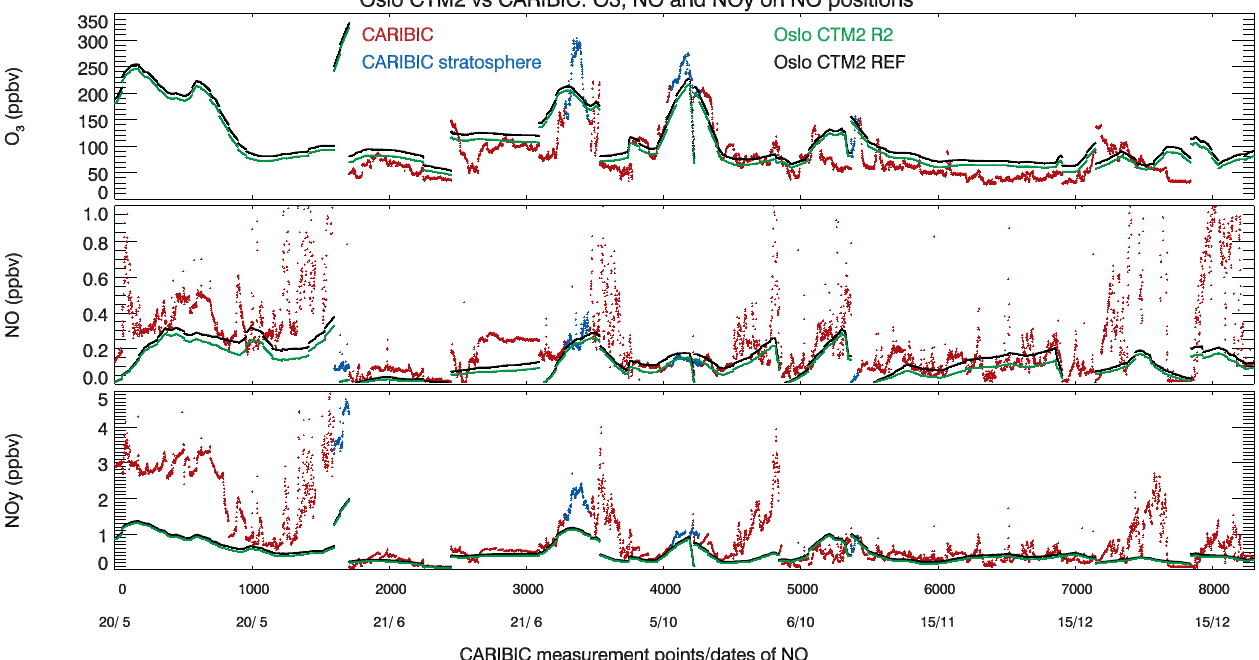
Fig. 7. A comparison of Oslo CTM2 on CARIBIC flight routes for 2005, on all measurement locations/times where NO was measured above 400hPa. Blue dots are measurements above the tropopause, as defined by the Oslo CTM2. Model results are produced at the same time and location as aircraft measurements.